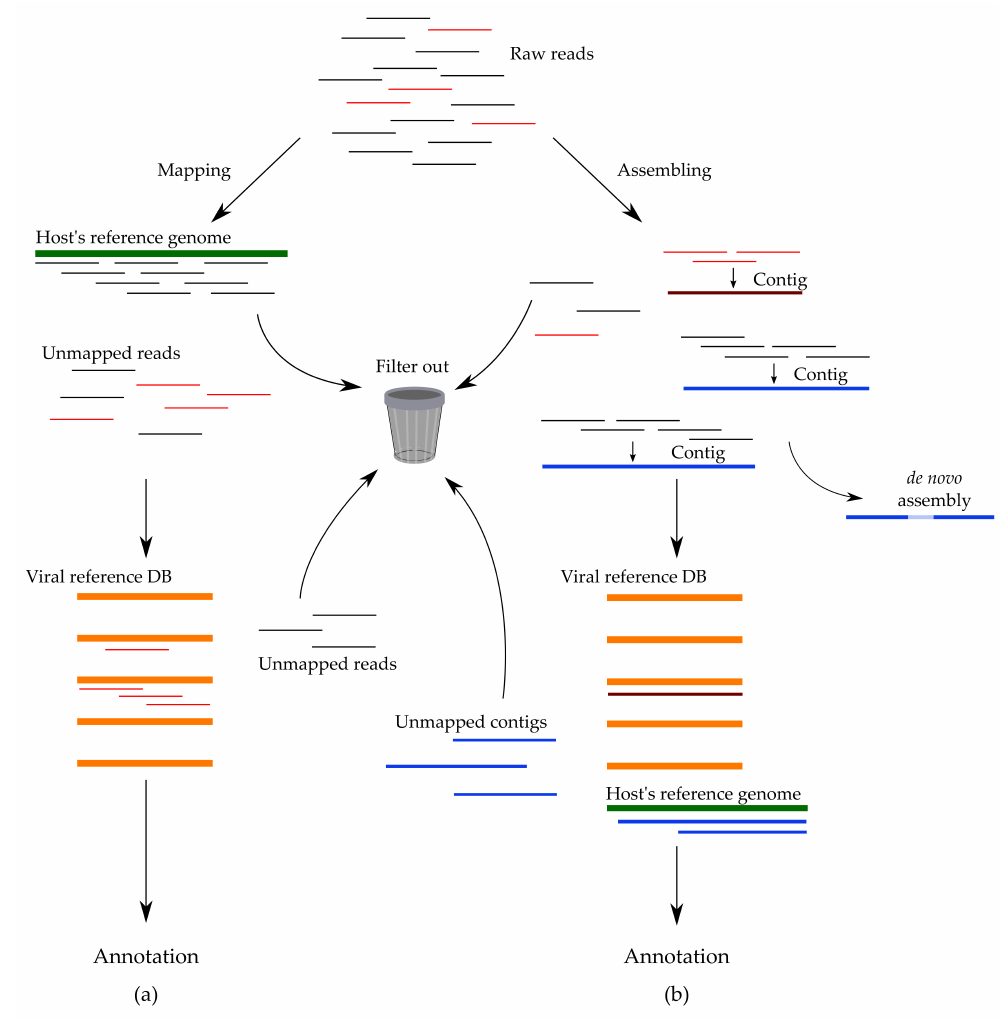
Figure 3. Pipelines for processing reads utilize two main strategies for filtering out “junk” data: ( a ) mapping raw reads onto the reference genome of the host and removing them, while preserving unmapped sequences for further analysis; ( b ) assembling short reads into contigs and comparing them against the host’s reference genome. Annotation follows both